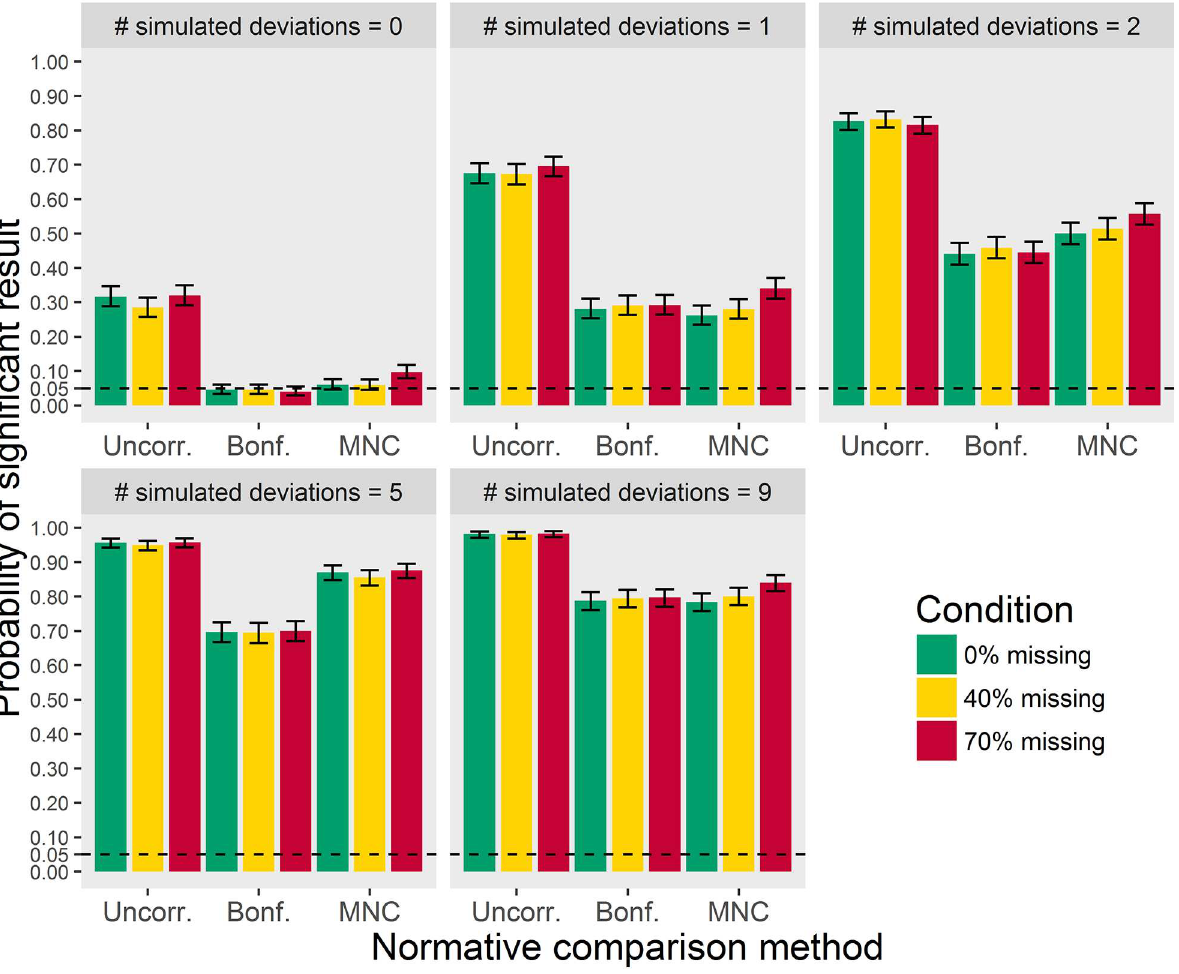
Fig 3. False positives (where number of deviations = 0) and sensitivity (where number of deviations > 0) as a function of the number of simulated deviations, for 0%, 40% and 70% missing data in the norm group. Error bars represent 95% confidence